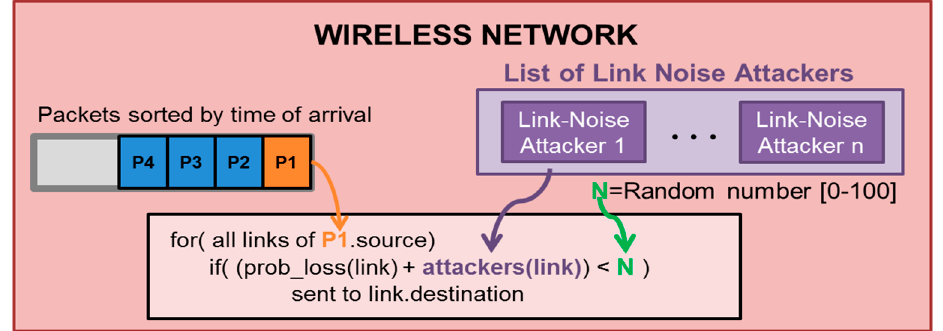
Figure 6. Network mode operation for Link Noise Attackers.